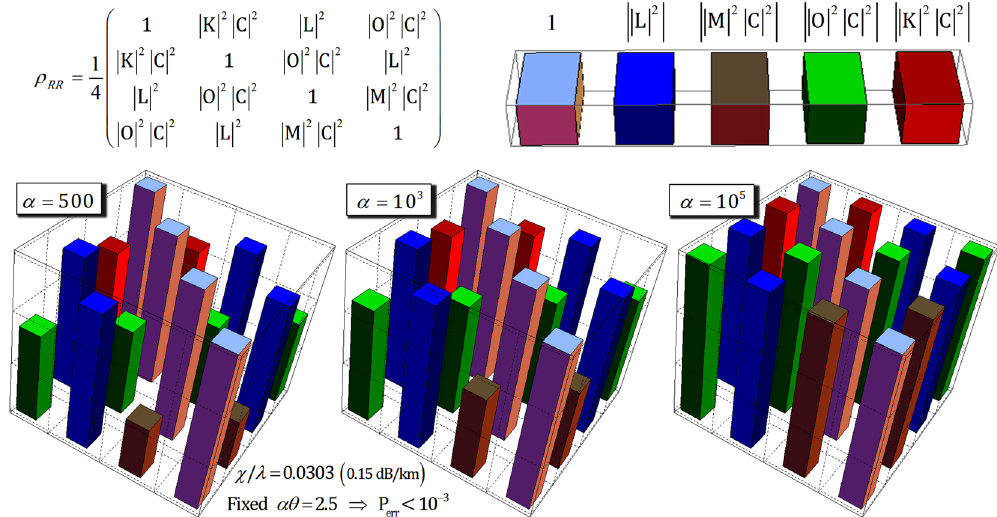
Figure 6. When the fixed parameter αθ = αχ t = 2.5 for P err < 10 − 3 and N = 10 3 in the optical fiber, χ / λ = 0.0303 (0.15 dB/km), the absolute values of the coherent parameters of ρ RR are plotted in diagrams depending on α = 500, 10 3 , and 10 5 .